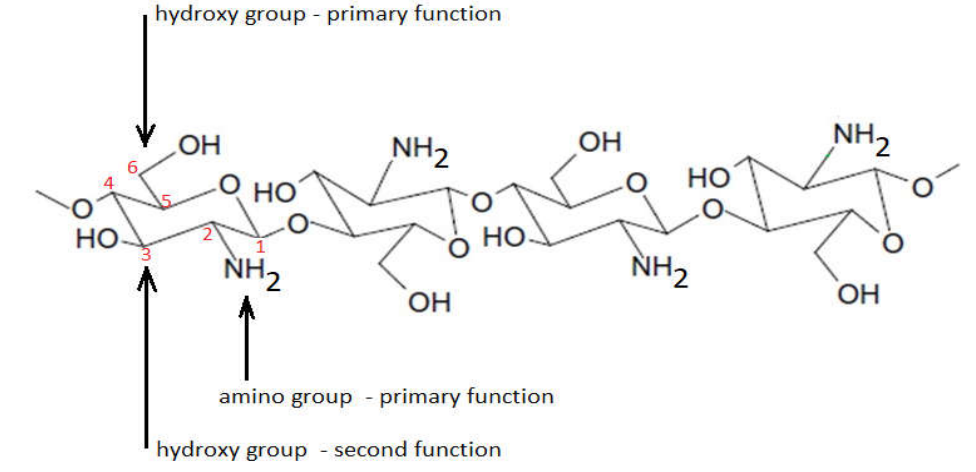
Figure 3. Linear structure of chitosan.